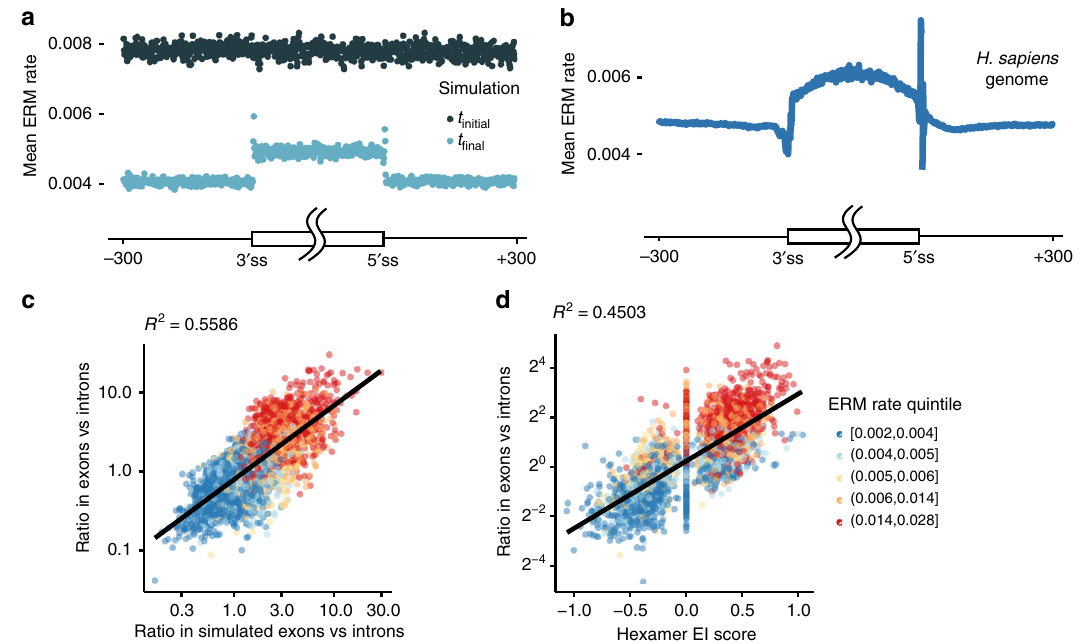
Fig. 2 Protein-coding regions exhibit higher mutability than non-coding regions. a Simulations initialized on a genome of random sequence ( t initial ) were run to model evolution with or without the constraint of maintaining protein identity ( t fi nal ). Mean ERM rate ( y axis) in aggregate simulation data with (exonic) or without (intronic) constraint was plotted as a function of position (Methods). b Mean ERM rate ( y axis) in aggregate human exon and intron data was plotted as a function of distance from annotated 3 ′ and 5 ′ splice sites. c Hexamers enriched in protein-coding versus non-coding simulations are positively correlated with hexamers enriched in human exons versus introns (Pearson ’ s correlation test, p < 2.2 × 10 − 16 , n = 4096 hexamers), and exhibit higher mutability (greater ERM rate quintiles). d Mutable motifs are enriched in exons versus introns and exhibit high ESE activity: hexamers with higher exonic spicing enhancer activity, as measured by EI scores ( x axis), are positively correlated with higher enrichment in human exons versus introns ( y axis) (Pearson ’ s correlation test, p < 2.2 × 10 − 16 , n = 4096 hexamers), and exhibit higher mutability (greater ERM rate quintiles). Source data are provided as a Source Data fi